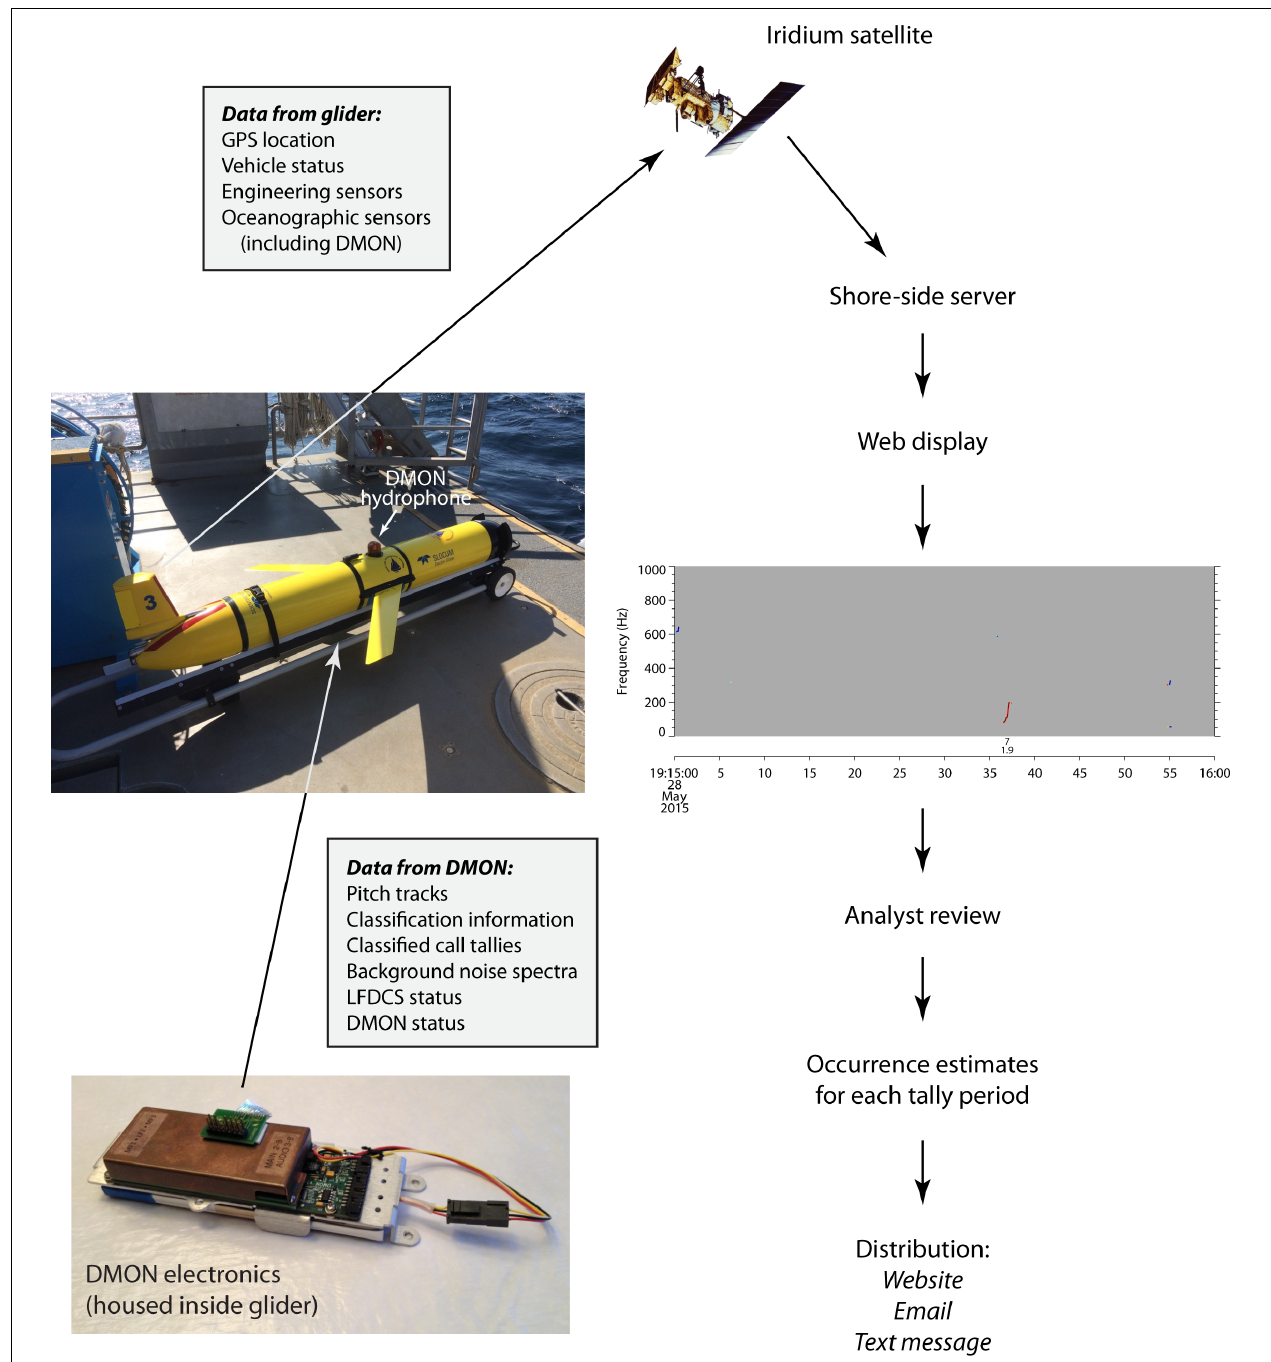
FIGURE 1 | Diagram of data flow from the DMON integrated in a Slocum glider to a shore-side server via the Iridium satellite service. These data are displayed on a website (dcs.whoi.edu), and pitch tracks and classification information are reviewed by an analyst to produce species-specific occurrence estimates for each monitored tally period. Occurrence estimates are then distributed to users via the same publicly accessible website as well as email and text messages. Web display in the figure shows a pitch track of a single North Atlantic right whale